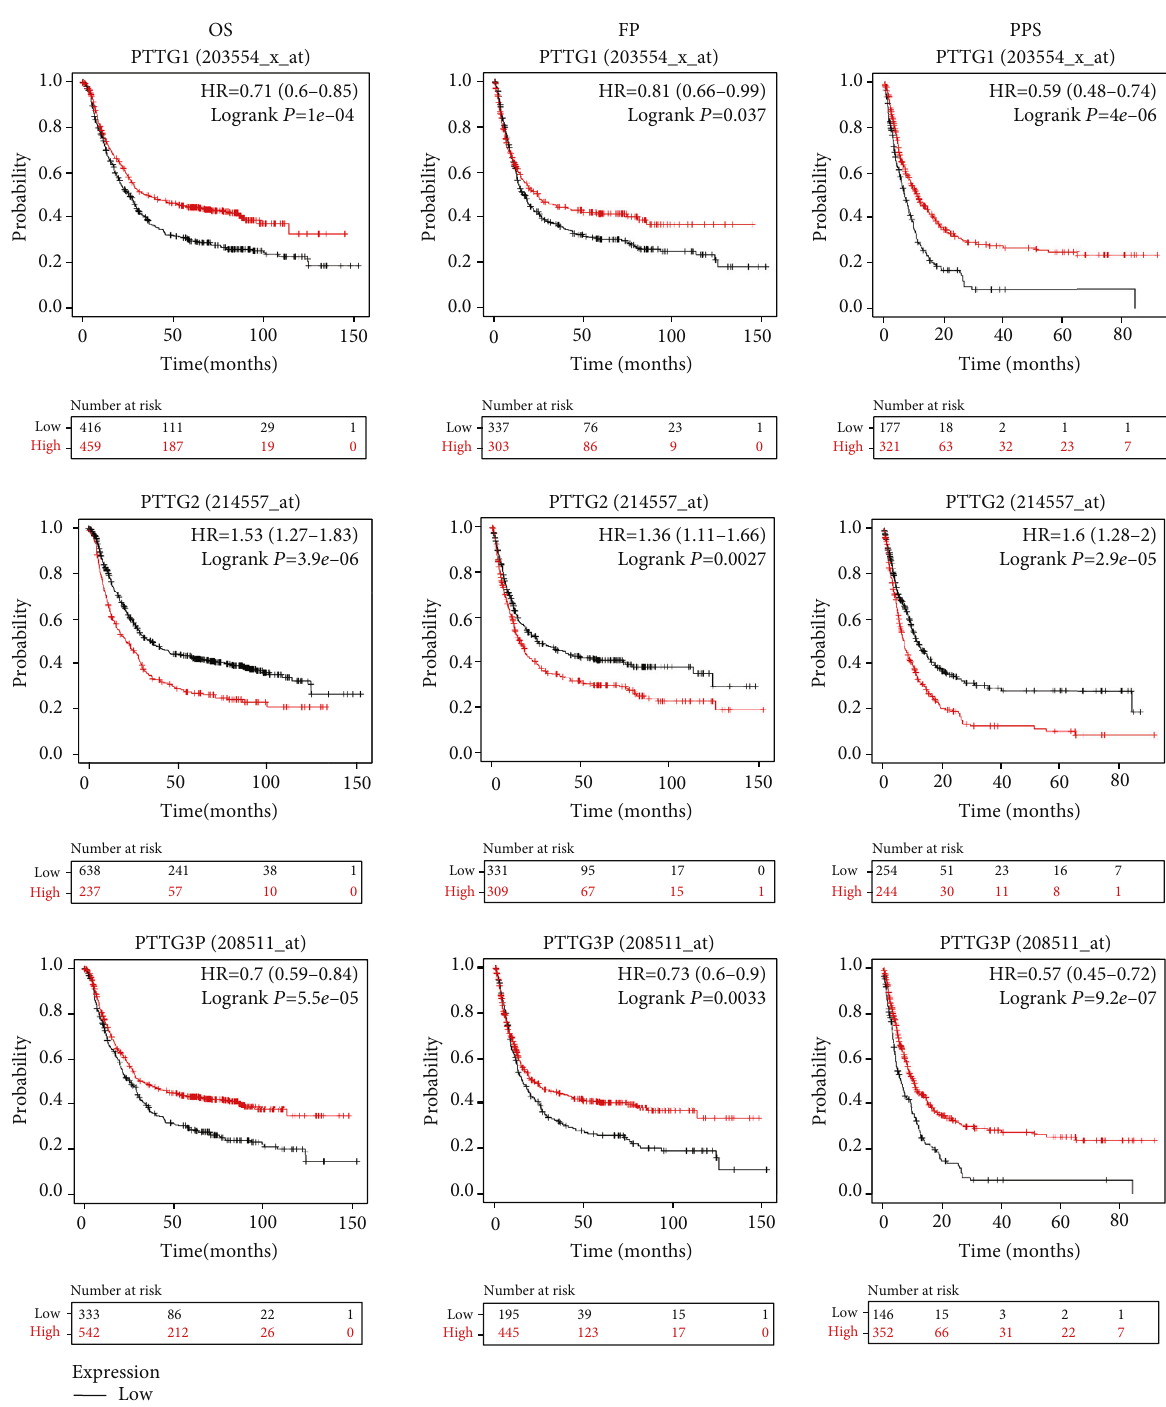
Figure 4: mRNA expression of PTTGs in GC patients has prognostic value (Kaplan-Meier plotter). The survival curves of GC patients were plotted in three di ff erent ways: for overall survival, progression-free survival, and survival after disease progression. JetSet ’ s top-tier probe set was selected for this investigation. The optimal cuto ff for dividing patients was determined by an algorithm. The OS curve was labeled as “ high ” if the expression level was above the cuto ff value and as “ low ” if the expression level was below the cuto ff value. Signi fi cant results were considered to be at the p < 0 : 05 level. Postprogression survival (PPS) is the time between the occurrence of the fi rst symptom and the patient ’ s